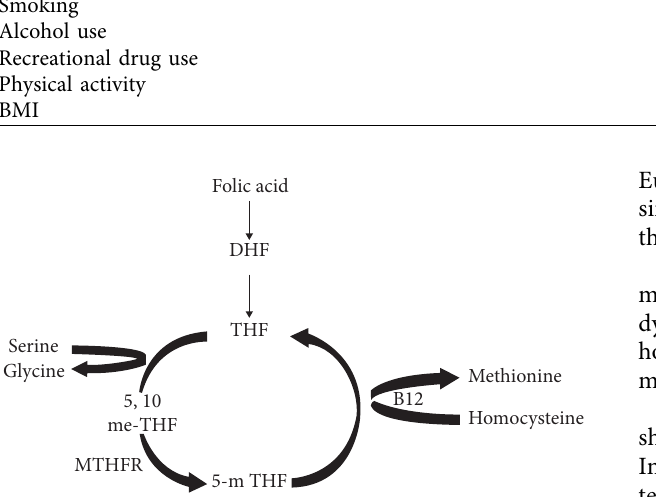
Figure 1: Folic acid is reduced to dihydrofolate (DHF) then to tetrahydrofolate (THF). THF is converted to 5,10-methylenete- trahydrofolate (5, 10-me-THF), which is then reduced to 5- methyltetrahydrofolate (5-mTHF) by MTHFR. 5-mTHF is demethylated to complete the folate cycle by donating a carbon into the methionine cycle through the methylation of homocysteine to methionine by methionine synthase and its cofactor vitamin